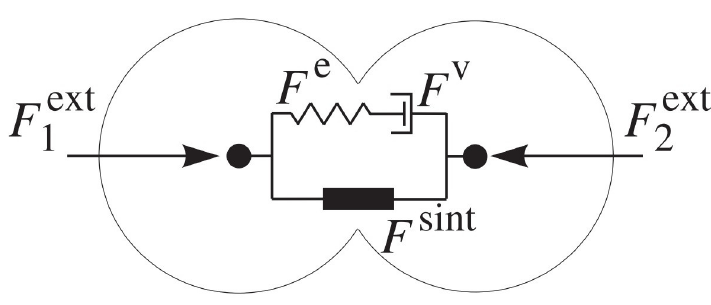
Figure 2. Rheological scheme of the viscoelastic model of pressure-assisted